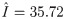
Effect of initial number of infecteds I0 on the dynamics for delay Δ = 2.Discrete- and continuous-time results are in blue and orange, respectively. Other parameters as in Fig 1. As in Fig 1, I^=35.72.